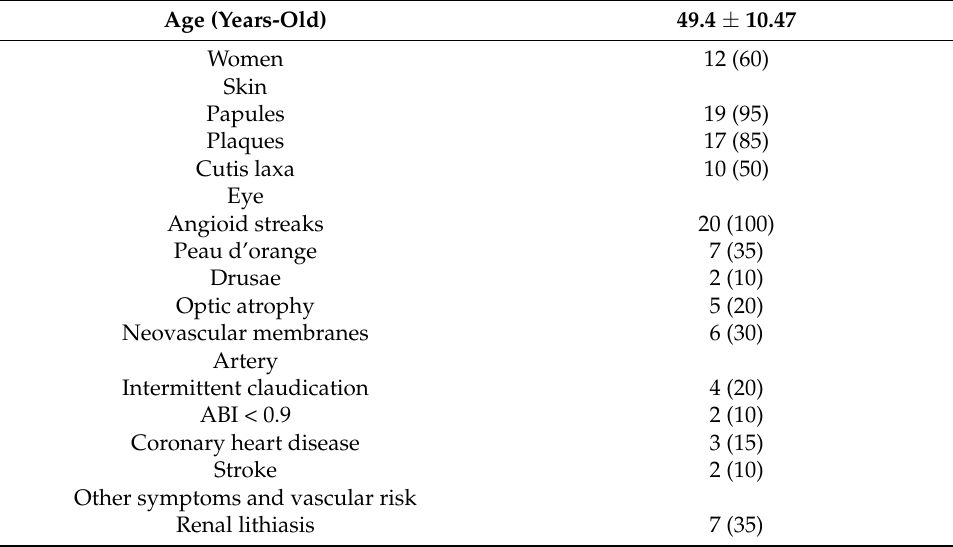
Table 1. Clinical characteristics of patients.